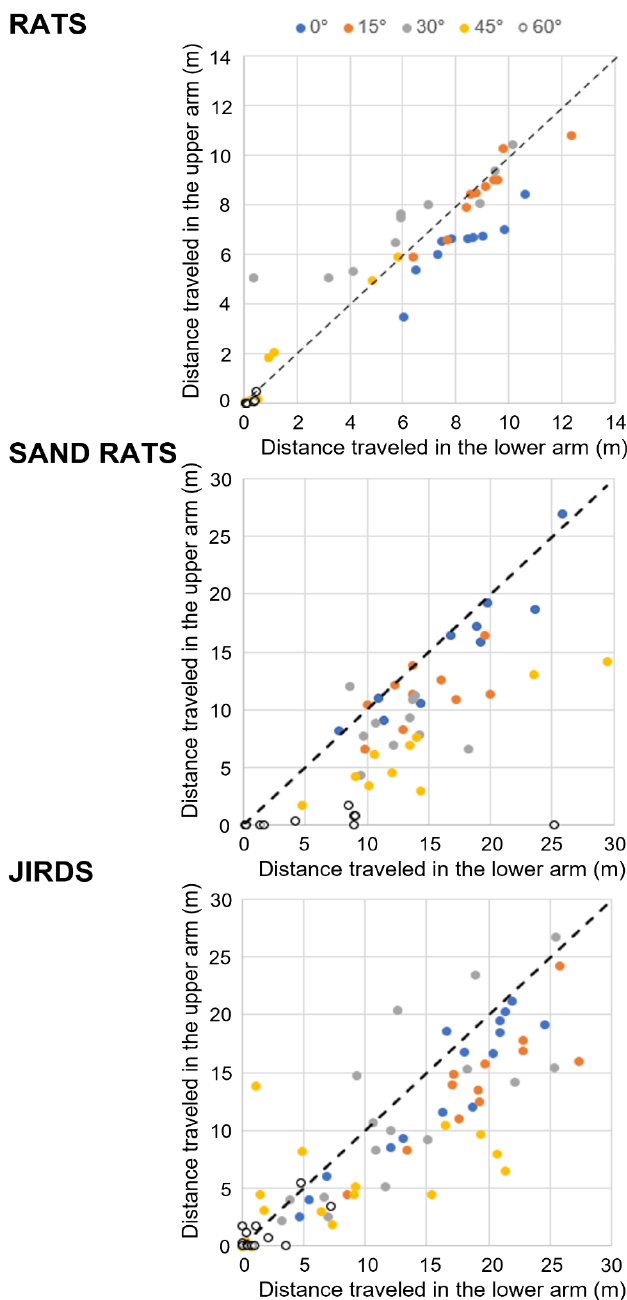
Figure 2. Distance traveled in the upper vs. the lower arm. In each inclination in each of the three species, the distance travelled by each rodent in the upper arm (ordinate) is plotted against the distance traveled by the same rodent in the lower arm (abscissa). Accordingly, for each species, each dot represents one rodent in one inclination. The various inclinations of the upper and lower arms are depicted at the top of the figure. The diagonal dashed line is the equivalence line along which the distance traveled in both arms was identical. As shown, rats aggregated near the line of equivalence, although those tested in 0 ◦ were blow the line (traveled a little more in the lower arm), those tested in 15 ◦ were on the line of equivalence, those tested in 30 ◦ were above the line (traveled a little more in the upper arm), while those tested in 45 ◦ and 60 ◦ ceased to travel in both arms. While the diminished travel in the higher latter inclinations is also apparent in jirds and sand rats, in the shallower inclination almost all sand rats and jirds aggregated below the line of equivalence (traveled greater distances in the lower